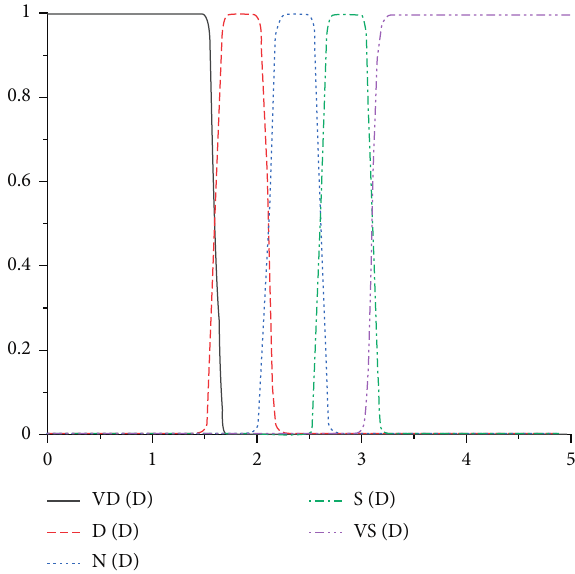
Figure 4: DCPA membership function image.